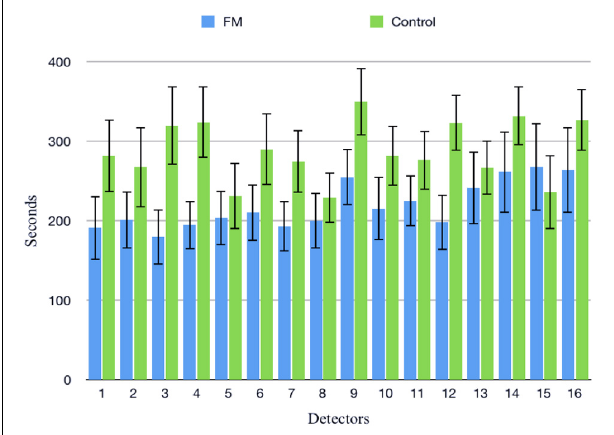
FIGURE 3 | Time taken to reach at peak oxy-hemoglobin concentration ( µ M) in patients and control during cold pressor test in fibromyalgia patients and control groups. Data are expressed as mean and standard error; detectors: functional near-infrared spectroscopy (fNIRS) detectors in the prefrontal